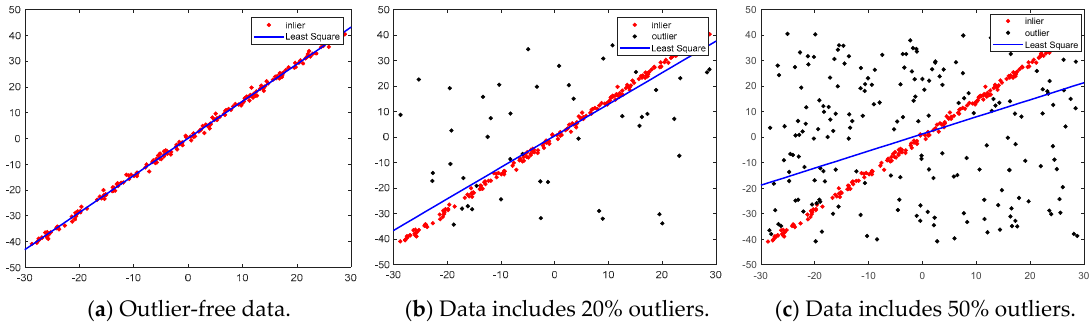
Figure 2. Least squares line fitting results under different degree of outlier contamination.